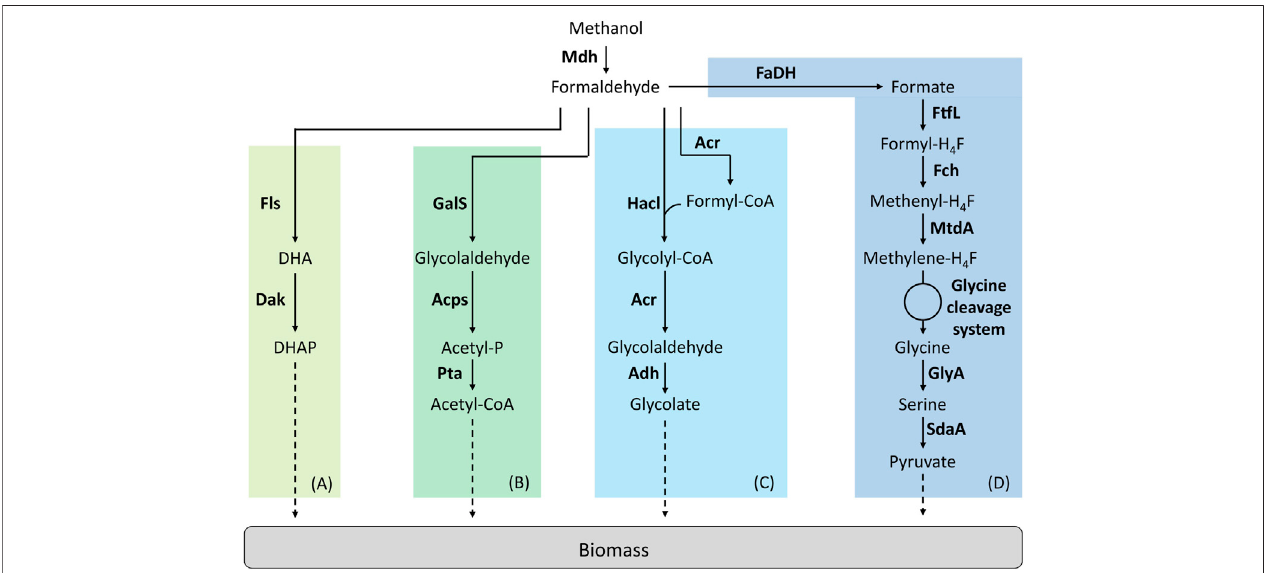
FIGURE 3 | Synthetic linear pathways implemented for C1-assimilation. (A) Formolase pathway, (B) Synthetic acetyl-CoA pathway, (C) 2-hydroxyacyl-CoA lyase pathway, (D) Reductive glycine pathway. Adapted from (Tuyishime, et al., 2020). Enzymes are written in bold. Acps, acetylphosphate synthase; Acr, acyl-CoA reductase; Adh, aldehyde dehydrogenase; Dak, dihydroxyacetone kinase; FaDH, formaldehyde dehydrogenase; Fch, methenyl H 4 F-cyclohydrolase; Fls, formolase; FtfL, formate-H 4 F ligase; GalS, glycolaldehyde synthase; GlyA, serine hydroxymethyltransferase; Hacl, 2-hydroxyacyl-CoA lyase; Mdh, methanol dehydrogenase; MtdA,